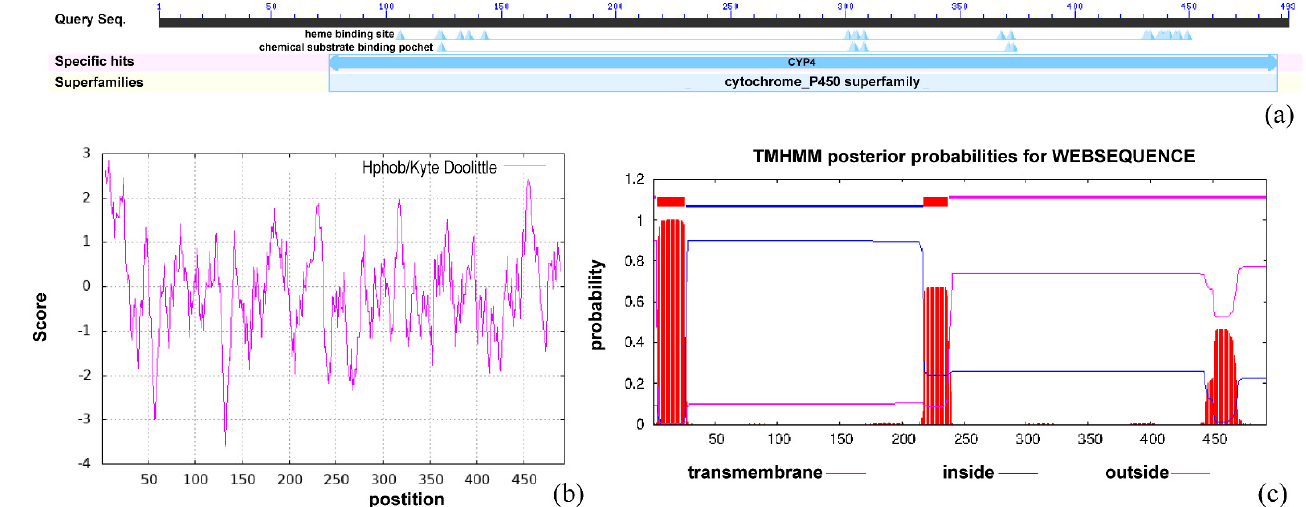
Figure 2. Physicochemical properties of Bx-cyp29A3 . ( a ) Conserved domains search result of Bx- cyp29A3 ; ( b ) ProtScale analysis result of Bx-cyp29A3 ; ( c ) TMHMM server analysis result of Bx-cyp29A3 .